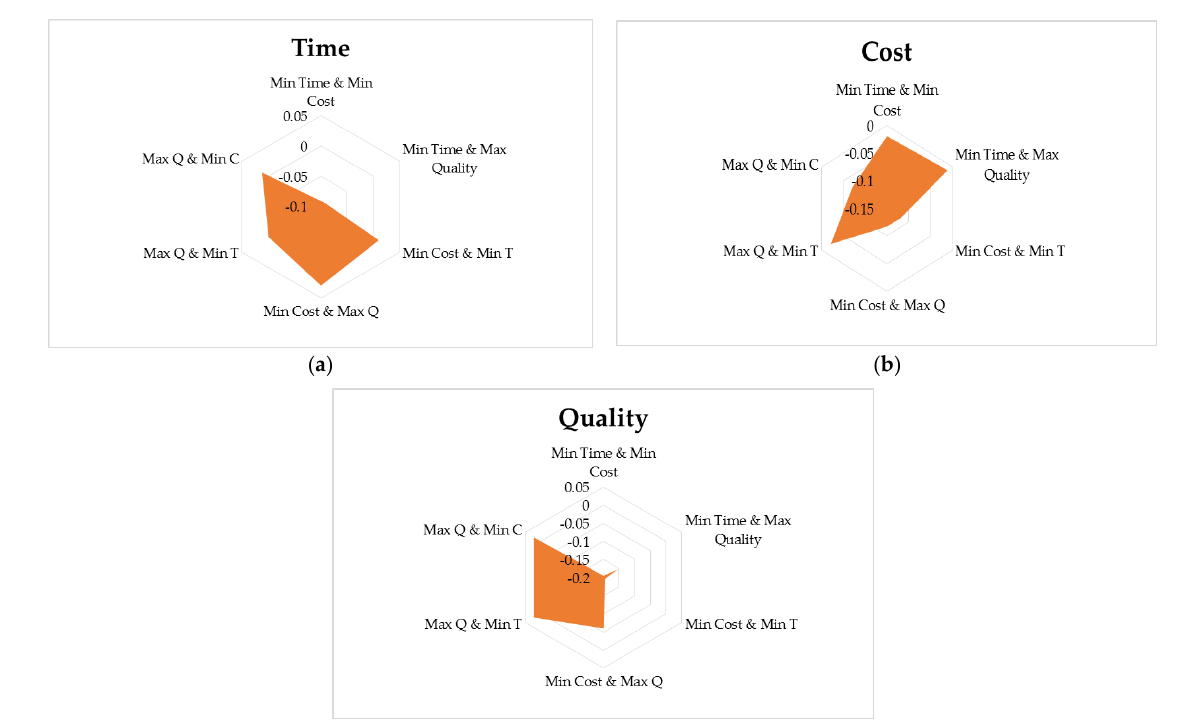
Figure 6. Sensitivity analysis of different methods in α -cut of 1 (project with 13 activities). ( a ) percentage of changes based on the total project duration. ( b ) percentage of changes based on the total project cost. ( c ) percentage of changes based on the total project